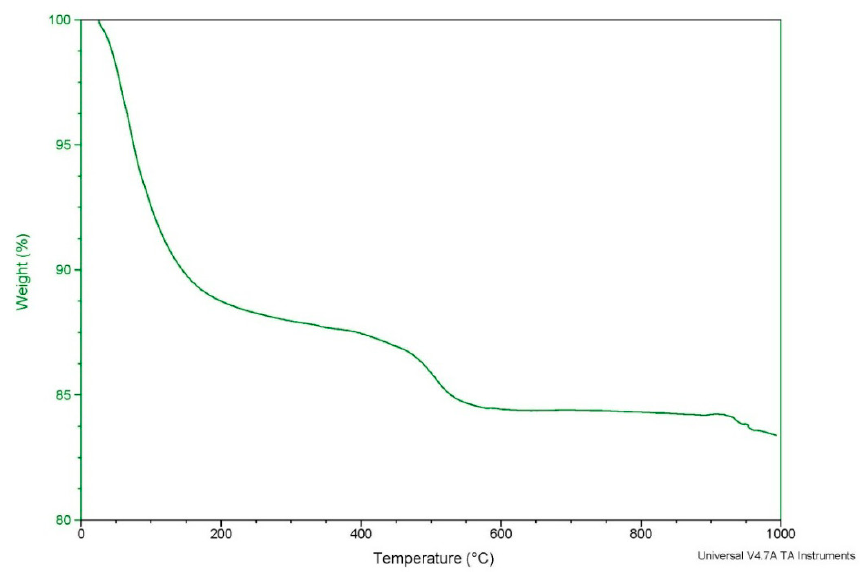
Figure 3. Thermogram of CsNa-1 from room temperature to 1000